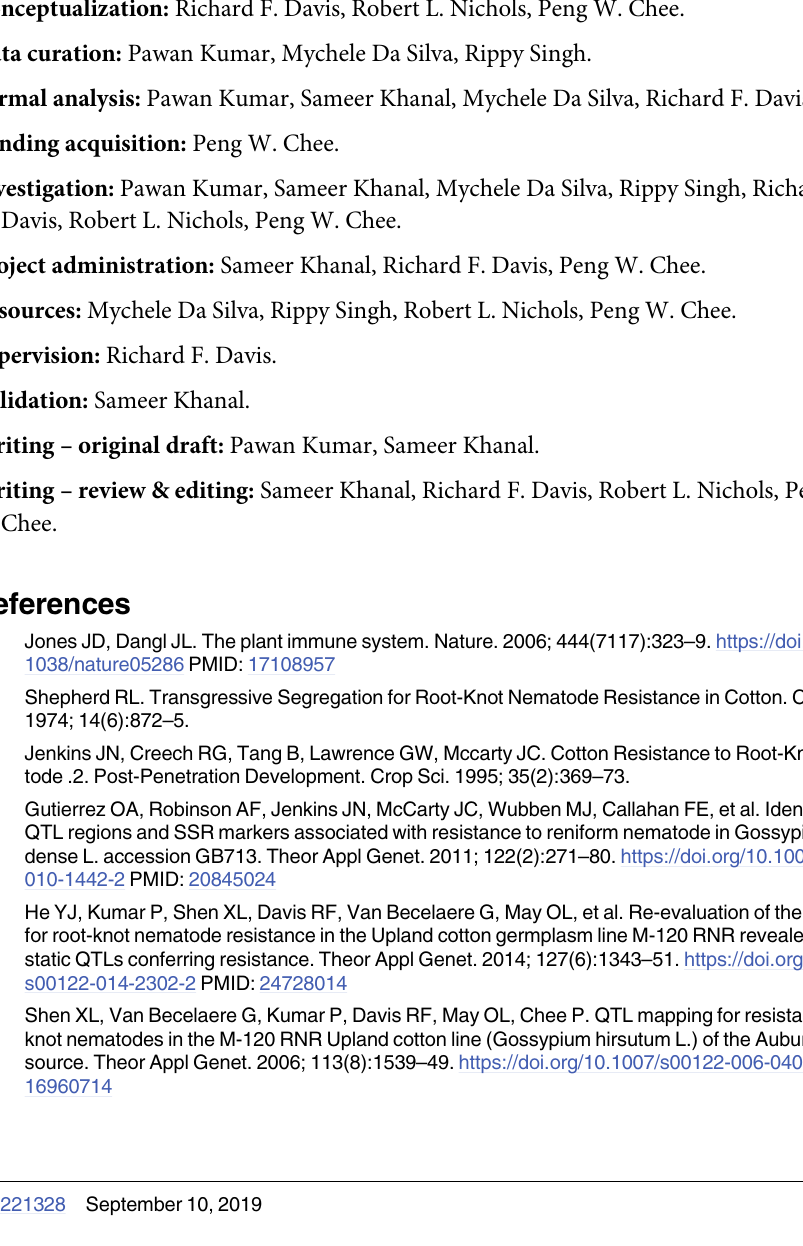
S3 Table. Relative gene expression in an early and late stage in M120 and C201 genotypes in response to root-knot